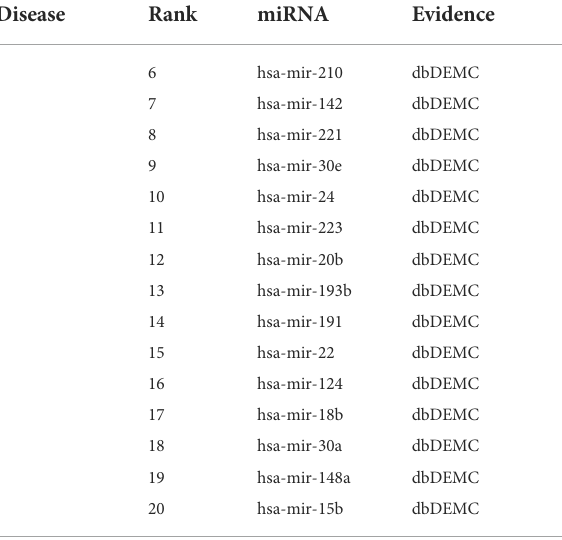
TABLE 4 ( Continued ) The top 20 miRNAs for three cancers predicted by the